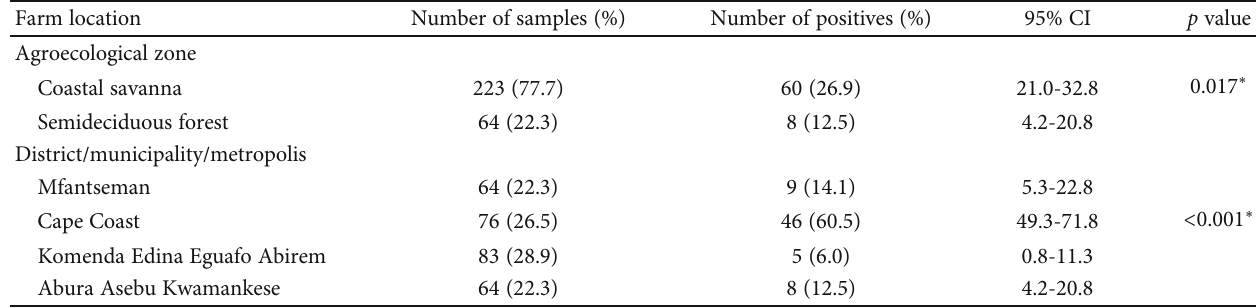
Table 2: Occurrence of Cryptosporidium infection in cattle by location of farm.